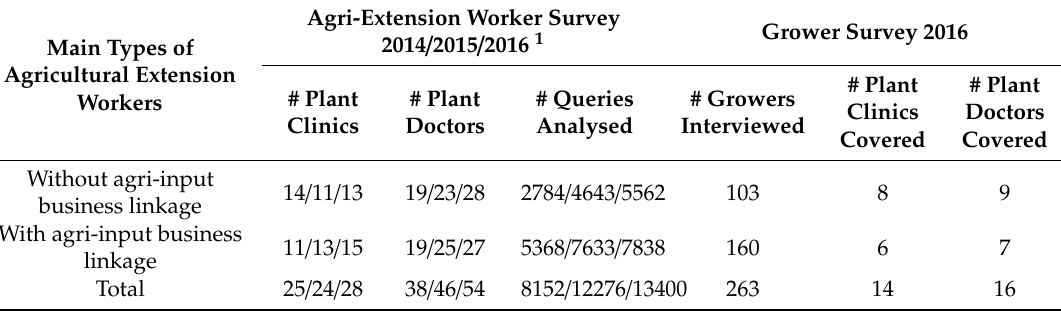
Table 1. Sample sizes of agricultural extension workers (here plant doctors) with or without linkage to agri-input businesses in Beijing municipality in China. Their prescription forms on plant health problem diagnosis and pest management advice issued to growers ( = queries) from 9 districts: Daxing, Miyun, Pinggu, Tongzhou, Changping, Huairou, Shunyi, Yanqing, Fangshan district, as well as the study population of interviewed growers consulting a subset of plant doctors in 5 districts: Yanqing (66 growers), Changping (6), Shunyi (80), Pinggu (64), and Fangshan